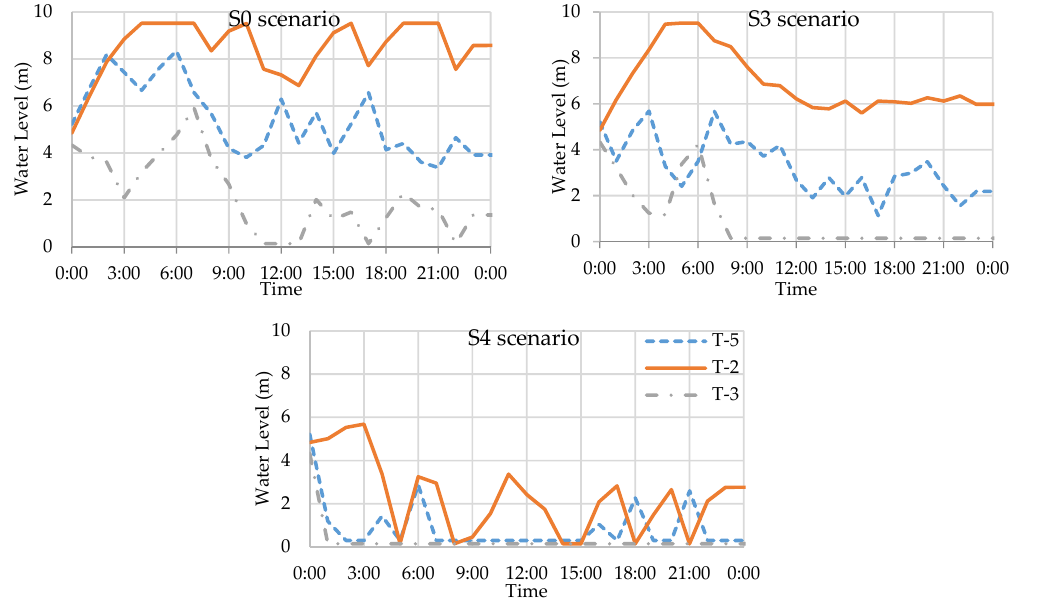
Figure 3. Typical water level pattern in tanks of S0 (top left), S3 (top right) and S4 (bottom) scenarios of the Monroe